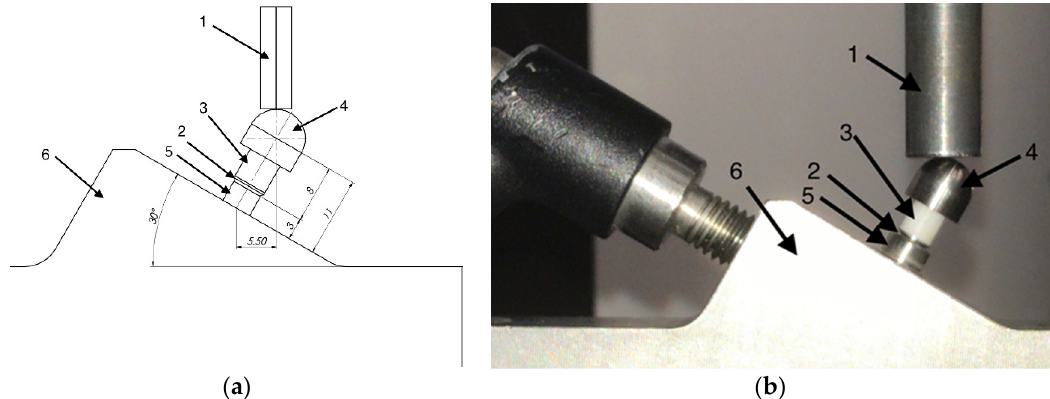
Figure 6. Test setup following ISO 14801:2016. ( a ) Schematic illustration of the test design: (1) loading device; (2) nominal bone level; (3) zirconia coping; (4) hemispherical loading member; (5) dental implant analog; and (6) metal specimen holder; ( b ) setup for the study.